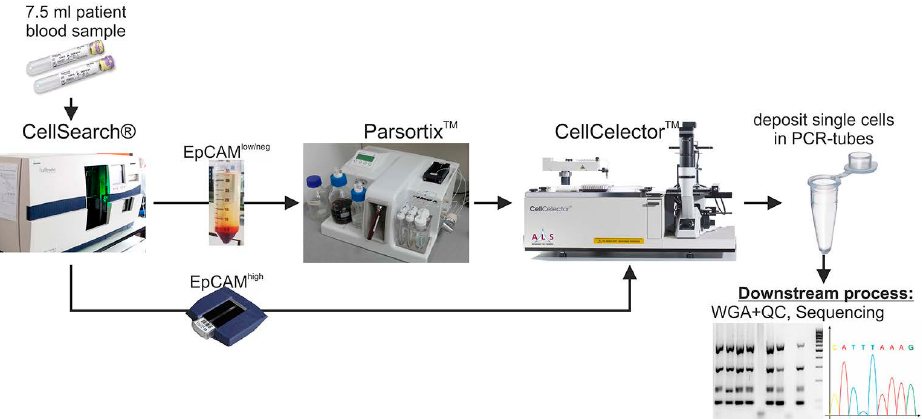
Figure 1. Parsortix™-CellCelector™ workflow. Patients’ blood samples are depleted of EpCAM high CTCs using CellSearch ® and enriched for EpCAM low/negative cells with the Parsortix™ system. Captured cells are stained for nuclei, cytokeratins, epithelial cell adhesion molecule (EpCAM) and CD45 within the Parsortix™ cartridge and then harvested. Tumor cells are detected and isolated via CellCelector™ micromanipulator into PCR tubes for further molecular characterizations. Inspired by our previous work [32].